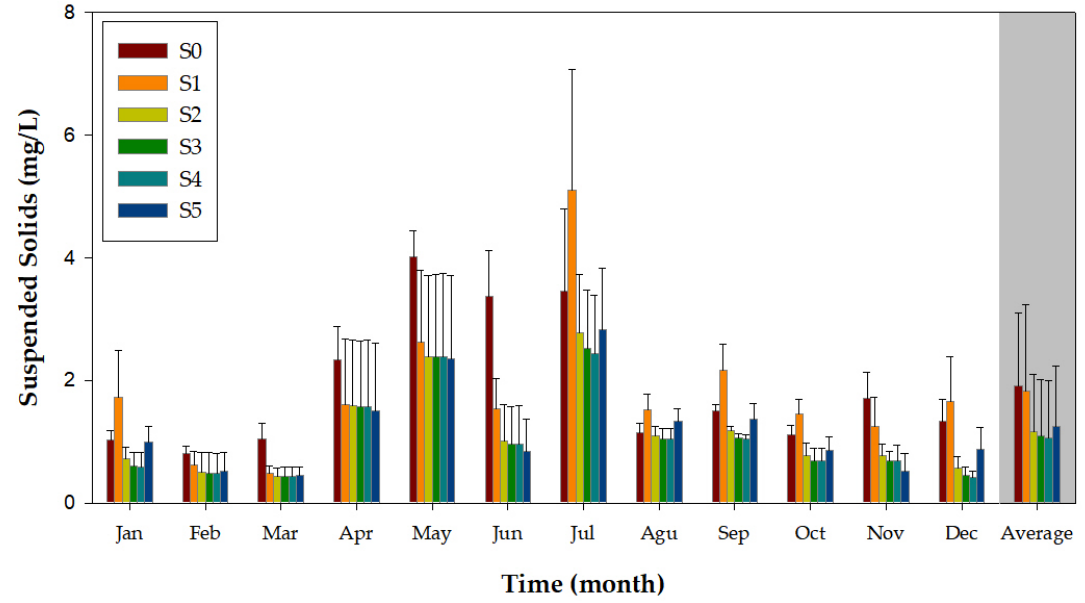
Figure 8. Comparison of changes in the monthly SS concentration at the DG2 site in Kangnung Namdae Stream.